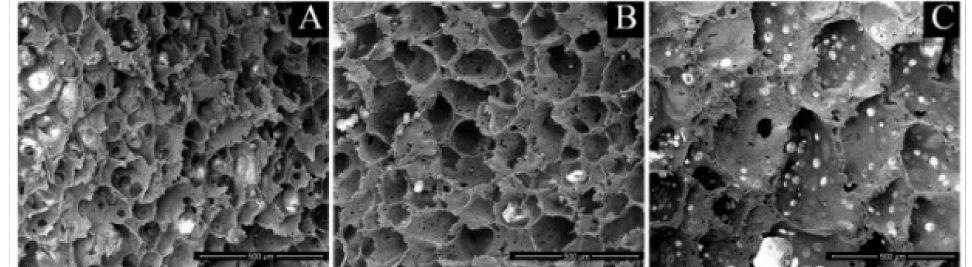
Figure 9. SEM micrographs of the scaffold prepared with a 90/10 PLLA/HA ratio at different demixing temperatures, keeping the demixing time constant. ( A ) 25 ◦ C; ( B ) 30 ◦ C; ( C ) 35 ◦ C. Reprinted with permission from Elsevier